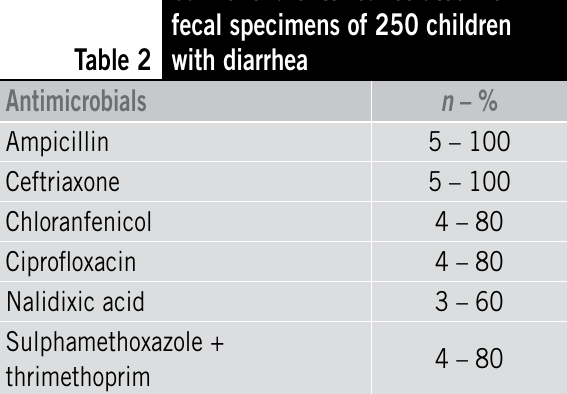
Antimicrobial susceptibility of Salmonella enterica isolated from fecal specimens of 250 children